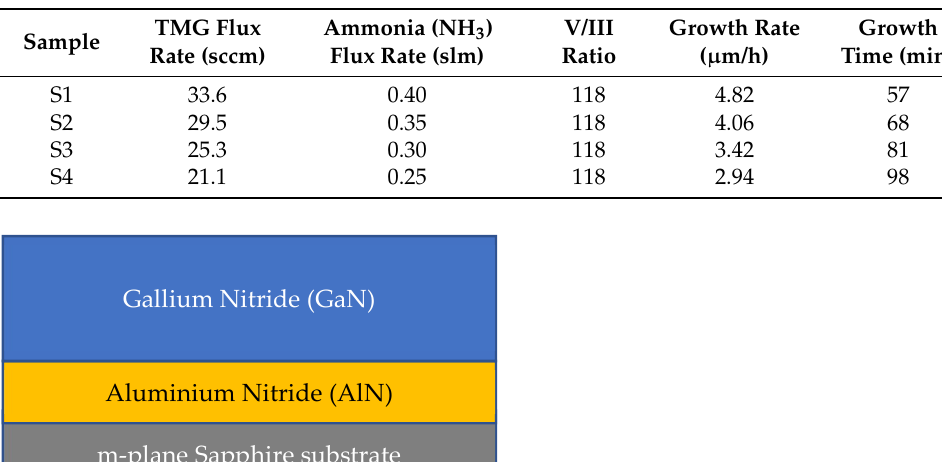
Table 1. Growth parameters variation adapted in this work.